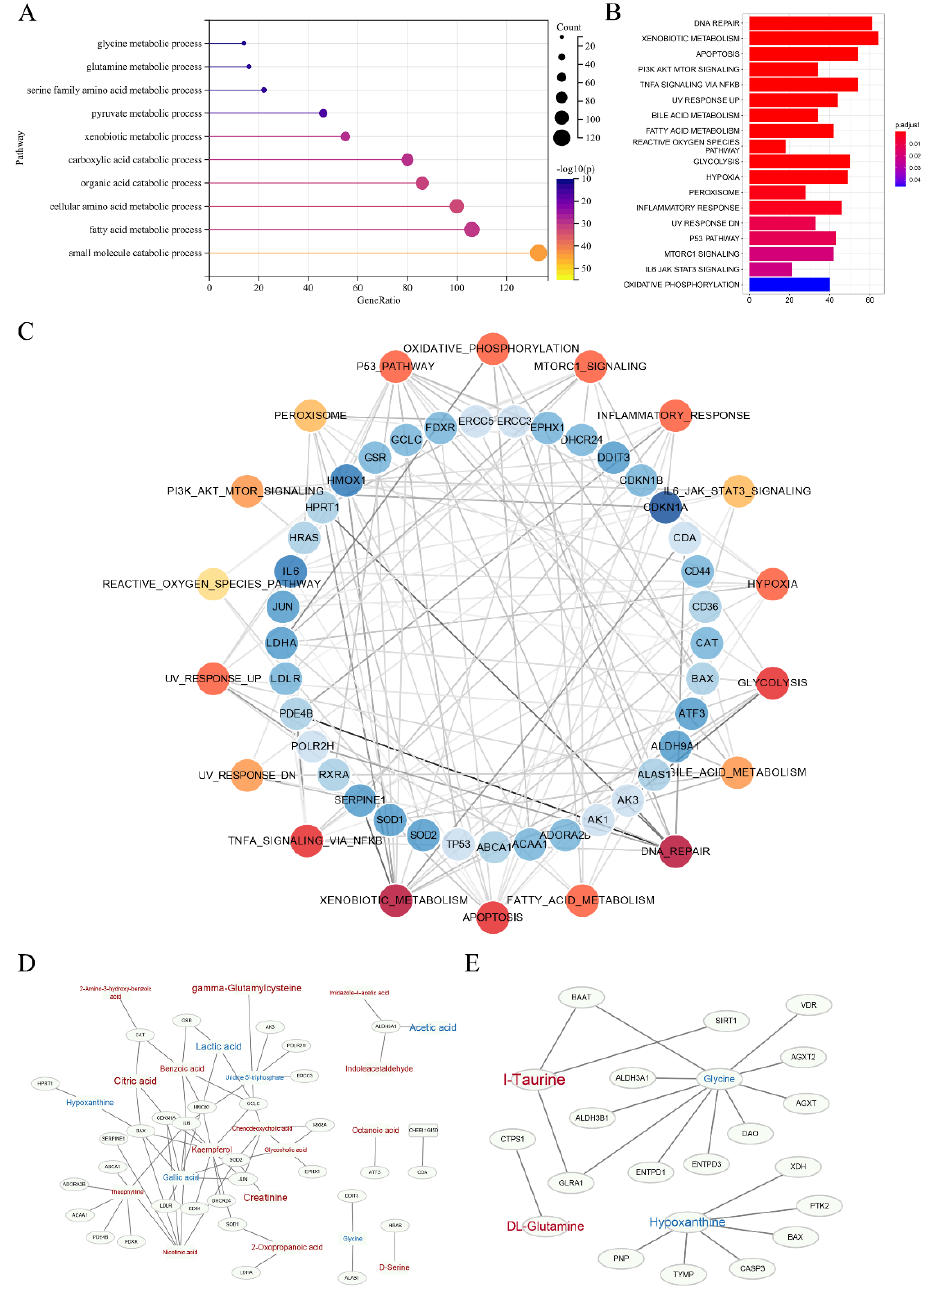
Figure 5. Enrichment analysis based on the self-built database, which integrated metabolites and proteins. ( A ) Summary of GO enrichment analysis. ( B ) Hallmark analysis of metabolites identified by UPLC-MS. ( C ) Detailed network diagram of genes related to pathways. Red dots represent pathways and blue dots represent genes. The darker the colour, the greater the degree. The shade of the line colour indicates edge betweenness. ( D , E ) The network of these significant genes and their related metabolites, and the four potential biomarkers and their related genes. Red represents the metabolites increasing in the sensitive group compared to the resistant group, while blue represents decreasing. The font size represents its significance.